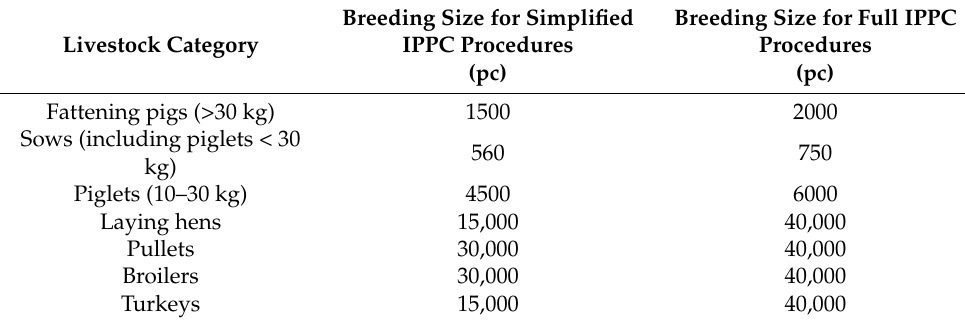
Table 1. Threshold capacities for integrated permits in Germany